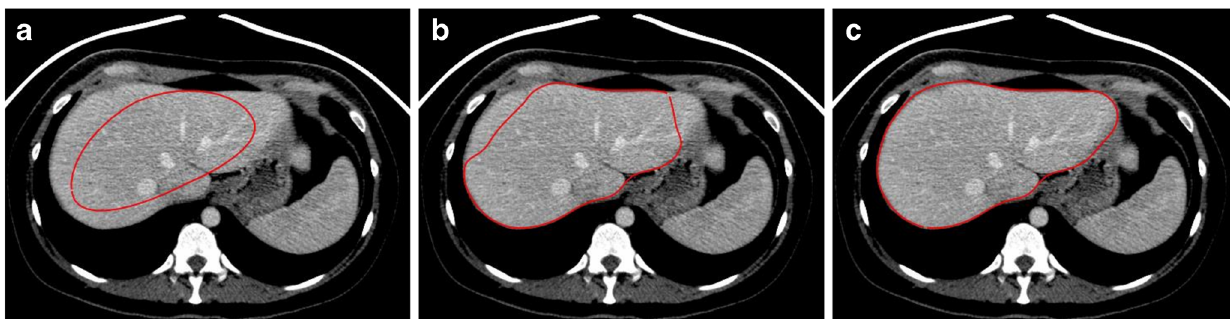
Fig. 9 Active contours technique. a Image analyst roughly contours the liver using a cursor. b Contour evolves based on salient image features. c The contour snaps to the true liver contour [13]